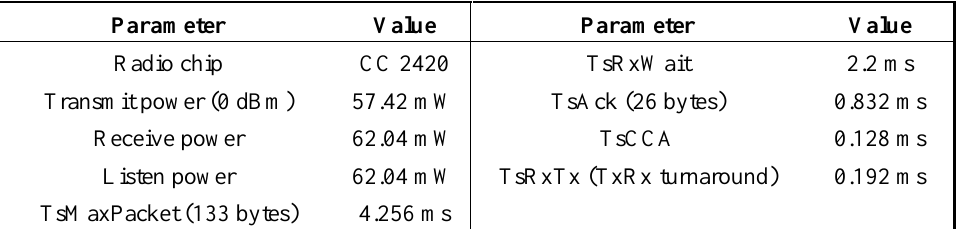
Table 7. Energy-consumption parameters.